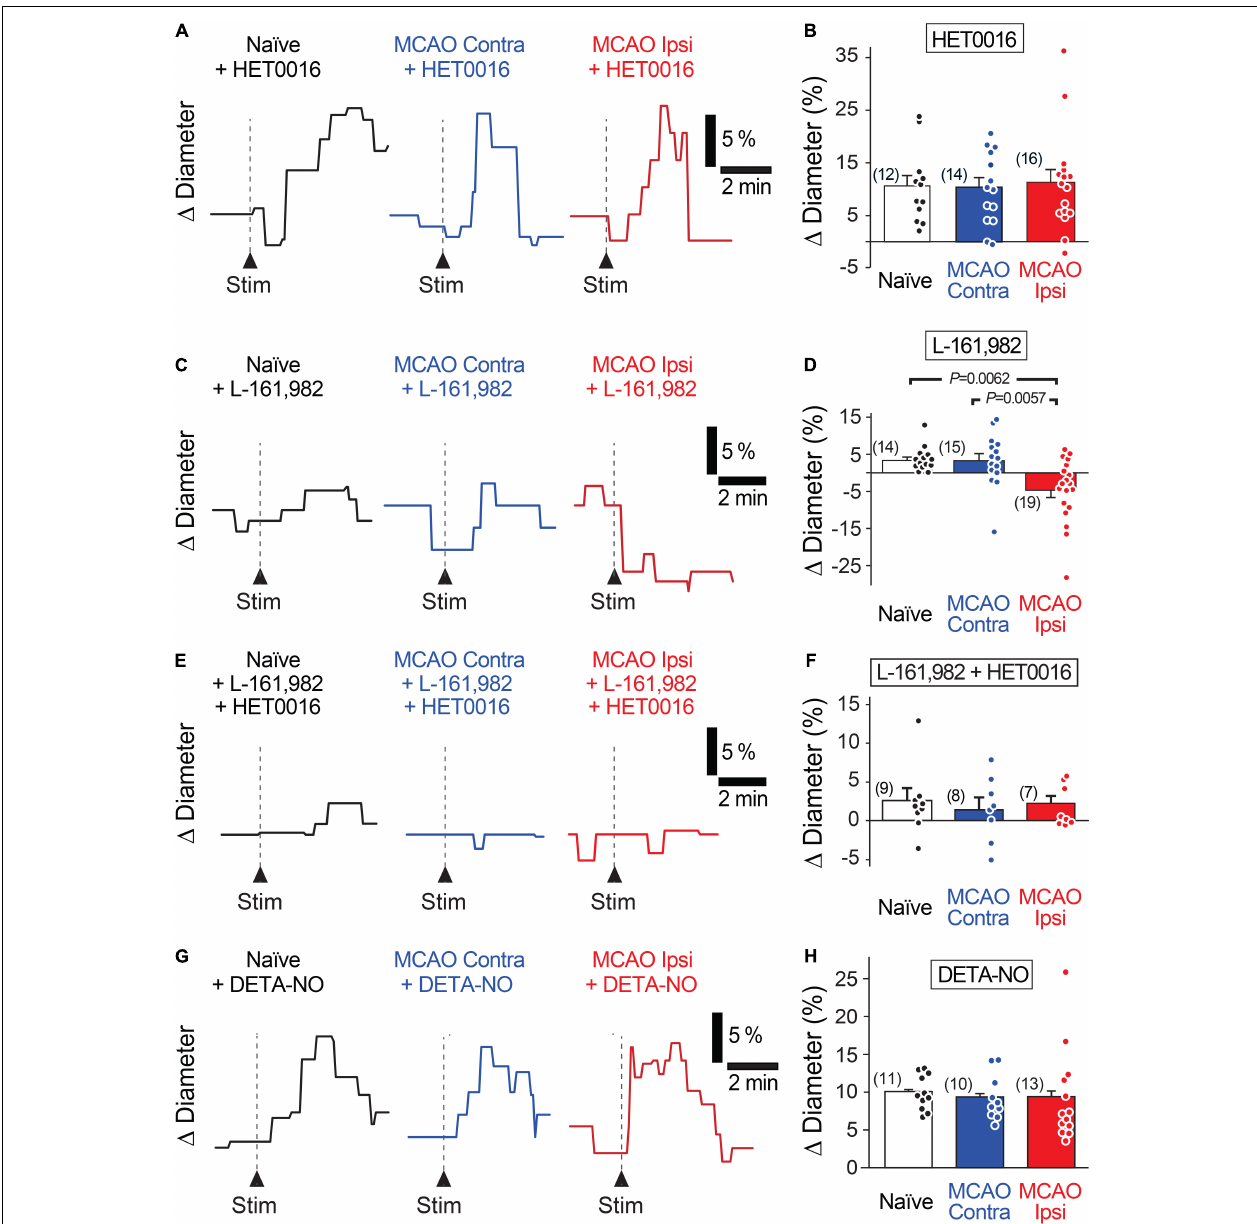
FIGURE 3 | Increased 20-HETE synthesis contributes to the reduction in neurovascular coupling in the MCAO Ipsi peri-infarct cortex. (A,B) HET0016 (200 nM), a potent inhibitor of 20-HETE synthesis, rescues neuronally evoked capillary dilations without altering responses in contralateral slices or naïve brains. (C,D) Blocking the EP4 receptor of PGE2 with L-161,982 (1 µ M) unmasks a 20-HETE-mediated constriction only in the MCAO ipsilateral peri-infarct region. (E,F) Inhibiting EP4 receptors and 20-HETE synthesis simultaneously prevents capillary response to neuronal activation in all three conditions. (G,H) Increasing NO concentration in the tissue with DETA-NONOate (DETA-NO, 100 µ M) restores stimulation-evoked capillary dilation in the MCAO ipsilateral hemisphere without altering capillary responses in contralateral or naïve brain slices. P -values were obtained from ANOVA followed by Tukey’s HSD test. Number in parentheses above each bar indicates N .